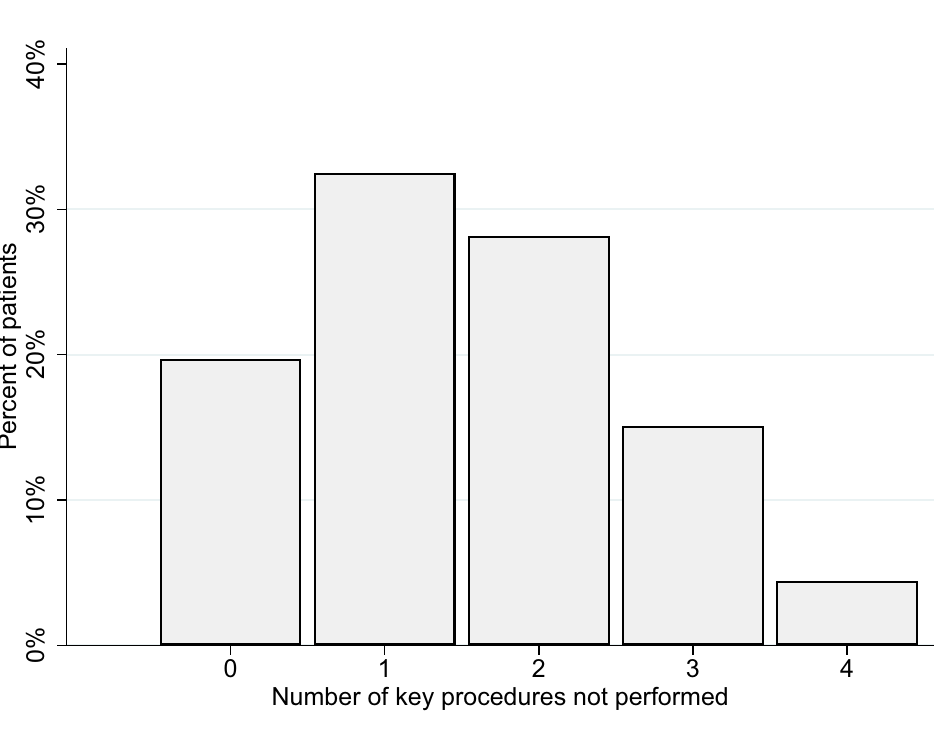
Fig 1. Distribution of patients according to number of non-completed or delayed key diagnostic procedures. Key procedures: triage within 15 minutes, examination by physician in accordance with urgency specified during triage, blood lactate measured within 1 hour, adequate observation regimen. N =